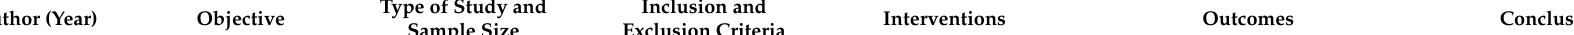
Table 2. Main studies based on microbiota composition in Bulimia nervosa and Binge Eating Disorder and microbiota